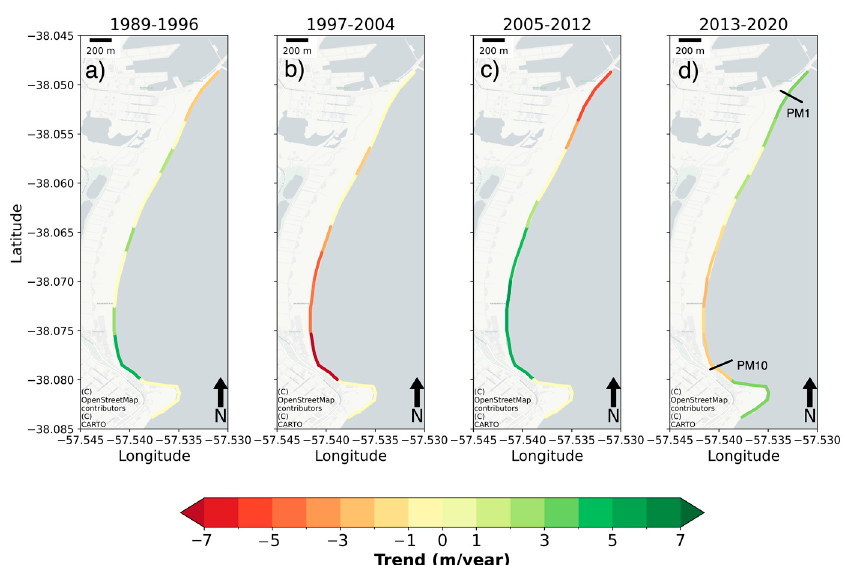
Figure 7. BWV trends in m/year at PM Bay: ( a ) 1989–1996, ( b ) 1997–2004, ( c ) 2005–2012, ( d ) 2013–2020. Negative trends are indicated by reddish colors and positive trends by greenish colors.